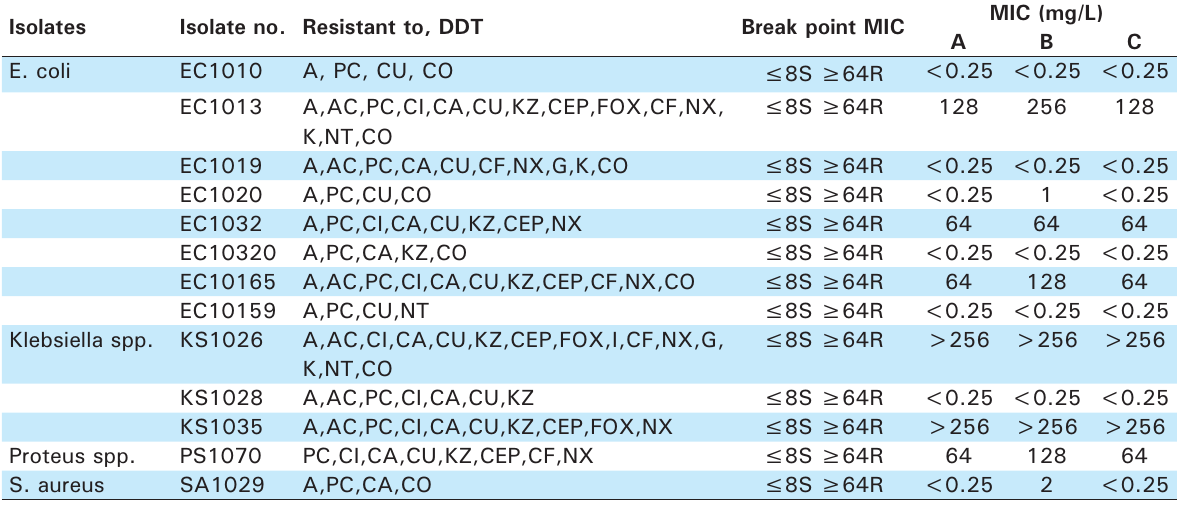
Table 1. Antibiotic resistance pattern and MIC of three brands of ceftriaxone against test isolates